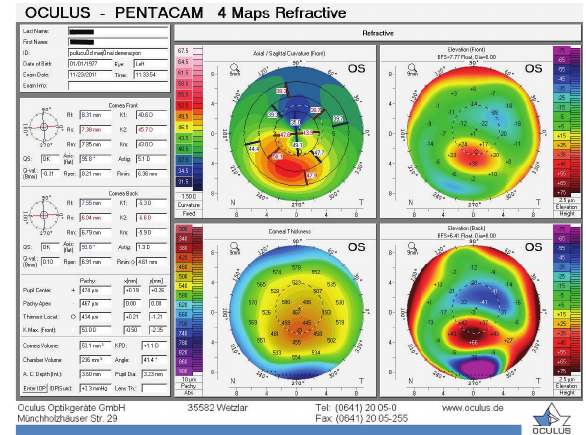
Figure 6: Patient 2, left eye before the treatment.